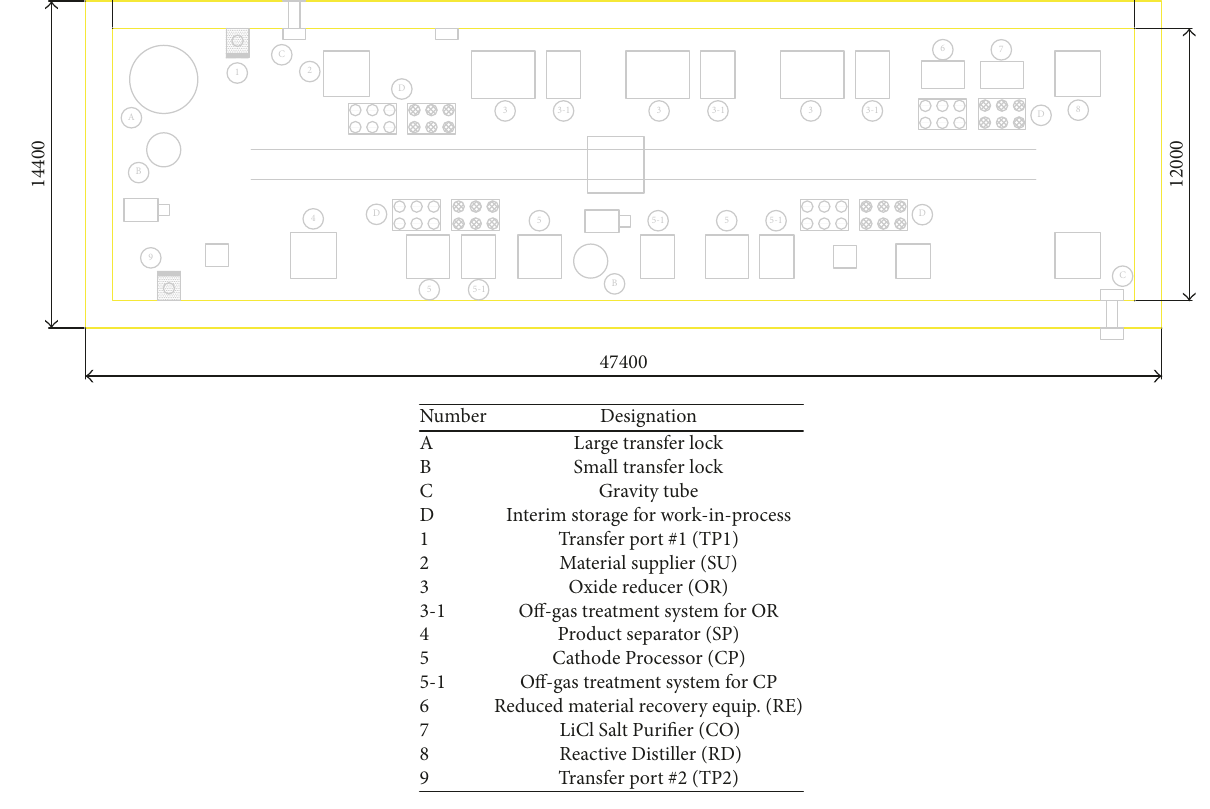
Figure 5: Drawing of the original layout design. Table 1: Equipment list for the oxide reduction